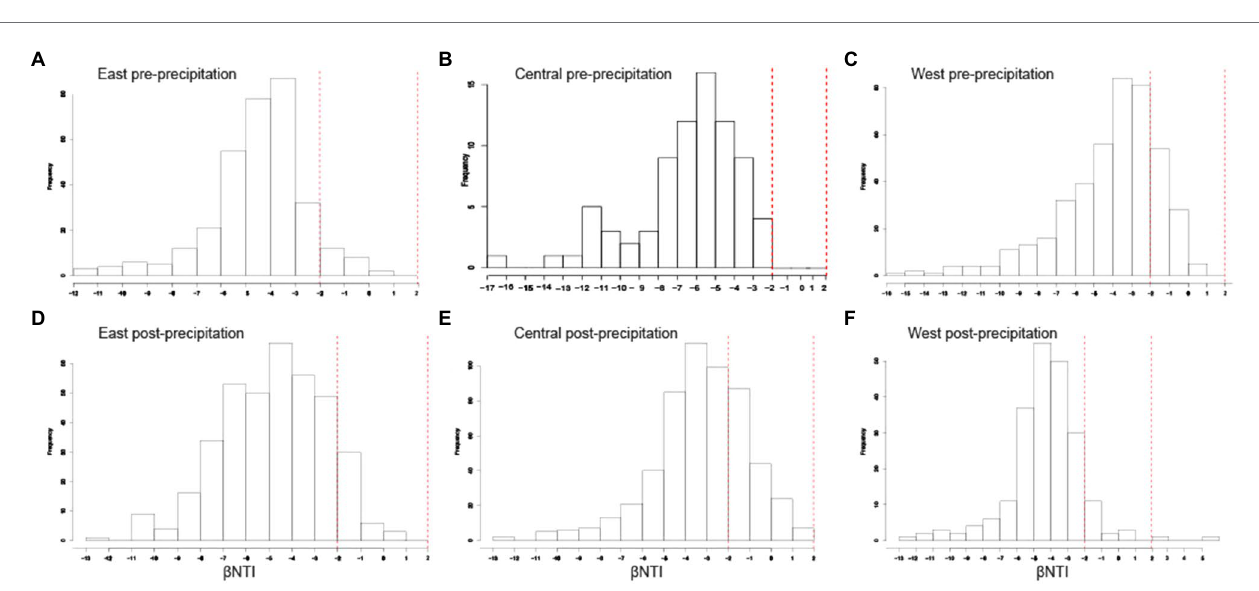
FIGURE 4 | Homogeneous selection was the dominant structural community assembly process. Histograms of β NTI values for each hillslope pre- (A-C) and post-precipitation (D-F) . β NTI values < − 2 indicate homogenous selection and those > +2 indicate variable